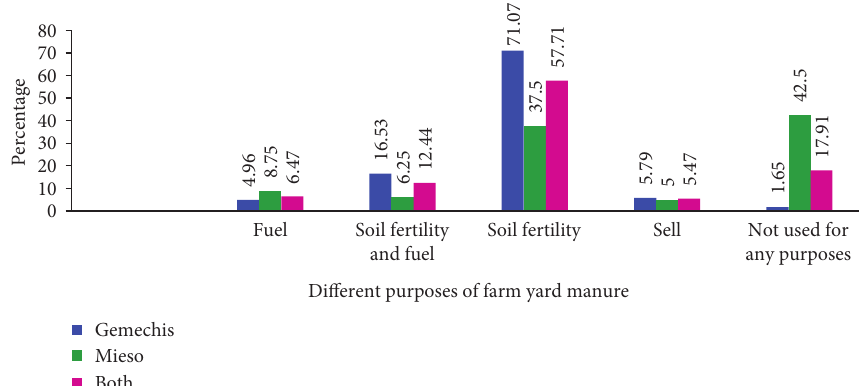
Figure 2: Purposes of farmyard manure. Source: survey result (2019).